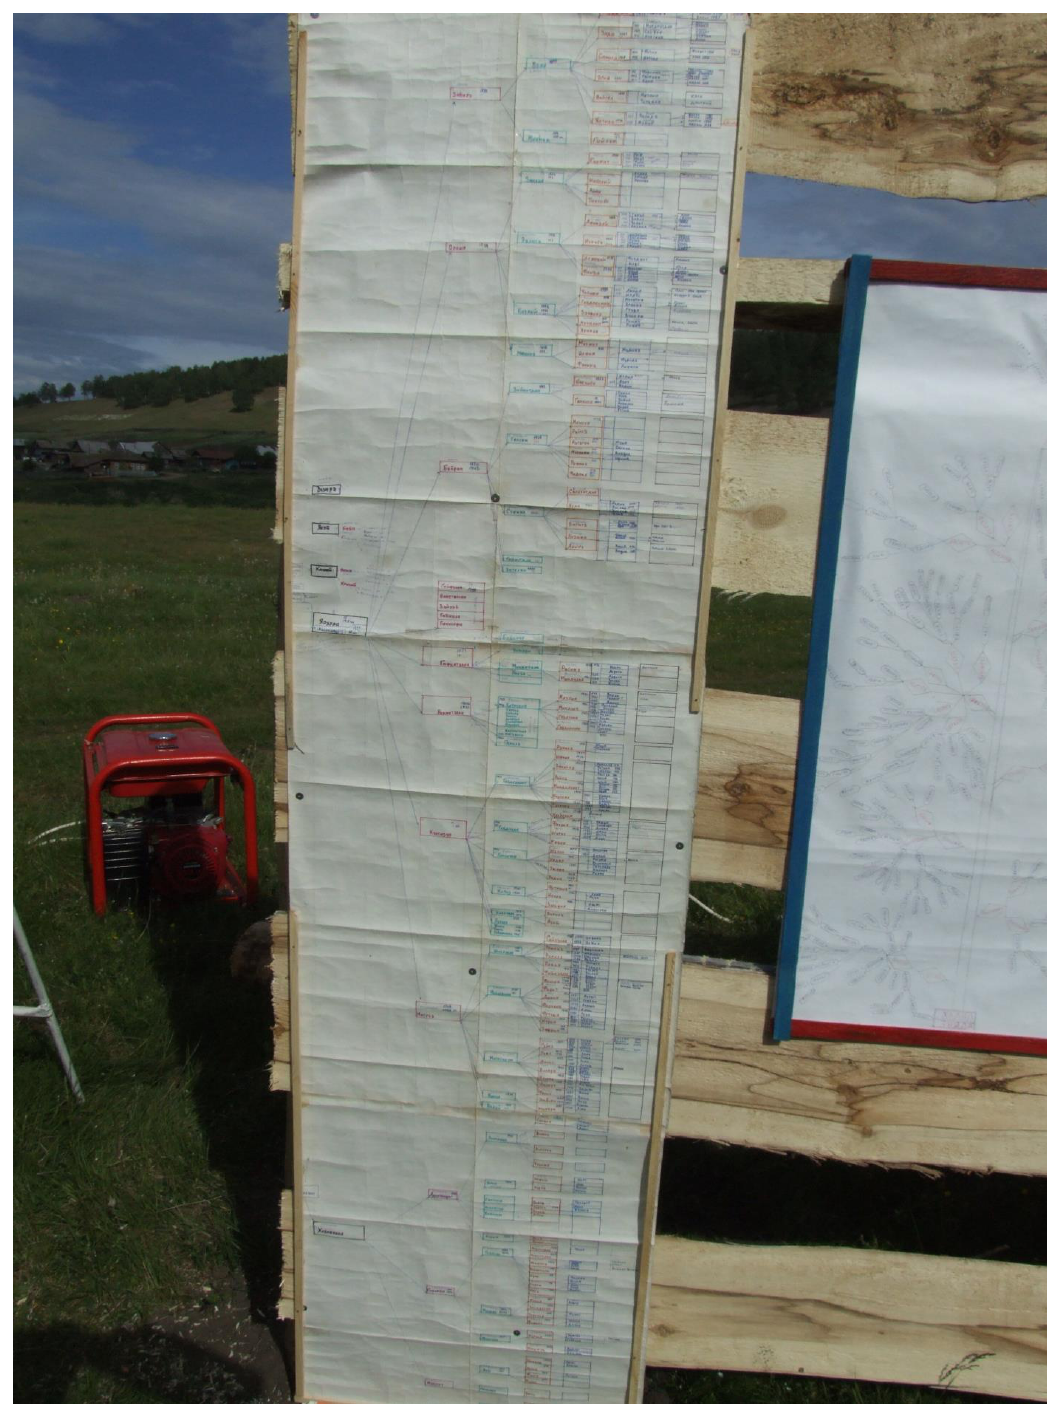
Figure 3. Lineage posters in public at the Sabantuj of Araslanovo, 2008.